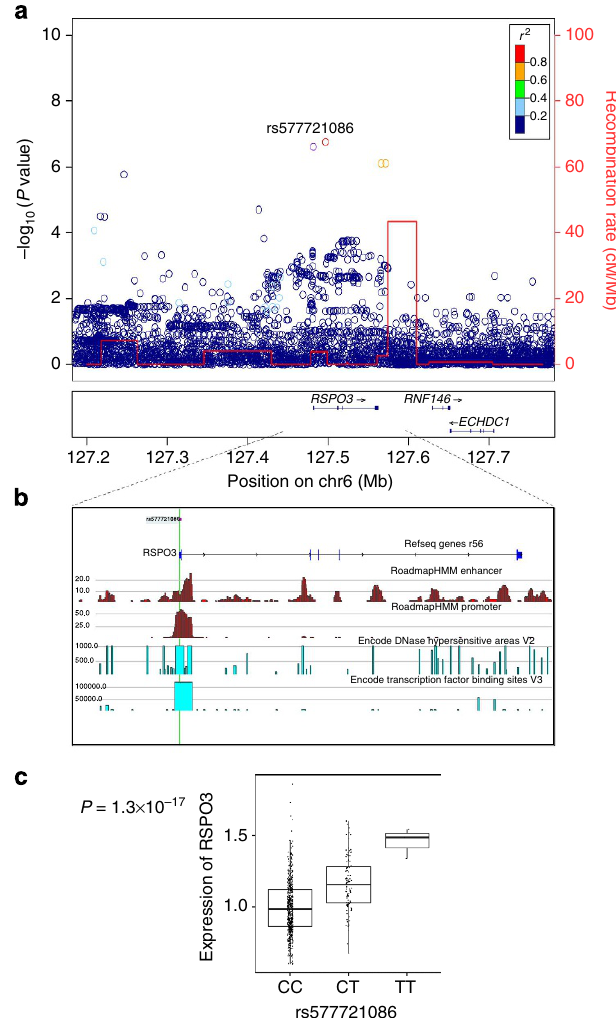
Figure 3 | Regional association plot for the 6q22.33 RSPO3 locus, potential functional elements and genotype-dependent expression. ( a ) Regional association plot for the 6q22.33 RSPO3 locus. P values ( (cid:3) log10) of SNP association with spine BMD in the Icelandic discovery samples are plotted against their positions at the 6q22.33 locus. SNPs are coloured to reflect their linkage disequilibrium (LD) with rs577721086 in the data set. The red line indicates recombination rates, based on the Icelandic recombination map for males and females combined 47 , with the peaks indicating recombination hotspots defining LD blocks in Icelanders. Known genes in the region are shown underneath the plot, taken from the UCSC genes track in the UCSC Genome Browser. All positions are in NCBI Build 36 coordinates. The plot was created using a stand-alone version of LocusZoom software 48 . ( b ) Functional annotation of potential functional elements in the region. Transcription factor binding sites and DNase hypersensitive areas from the ENCODE data is shown 43,44 and enhancer and promoter states from the Roadmap consortium 26 . Location of rs577721086 is indicated by a green vertical line. ( c ) Genotype-dependent gene expression of the RSPO3 gene. P value is derived from regression of the MLR on the carrier status of rs577721086, adjusting for age and